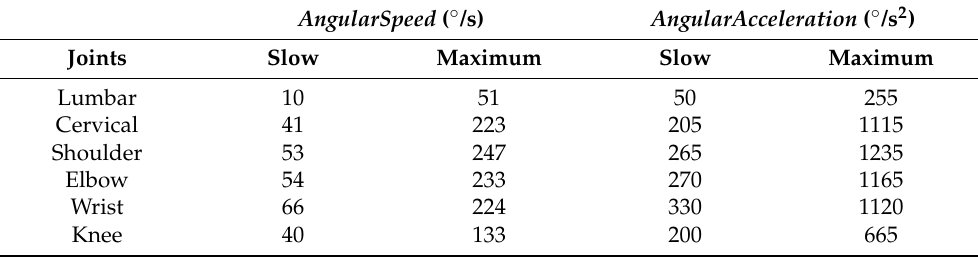
Table 9. Maximum and minimum angular velocities and